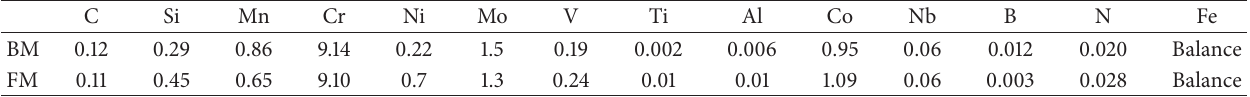
Table 1: Chemical composition in wt.% of CB2 steel BM and FM (Thermanit MTS 5 Co